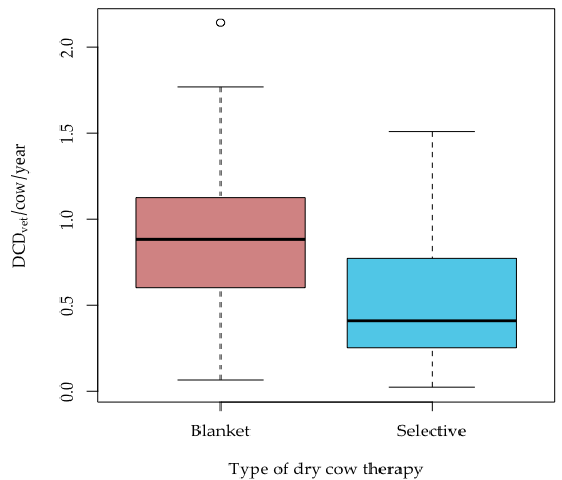
Figure 5. Defined Course Doses for individual herds for blanket and selective aDCT. Box = range between Q1 and Q3; horizontal line = median; lower whisker = Q1 − 1.5 (IQR) (interquartile range); upper whisker = Q3 + 1.5(IQR); circles = outliers.